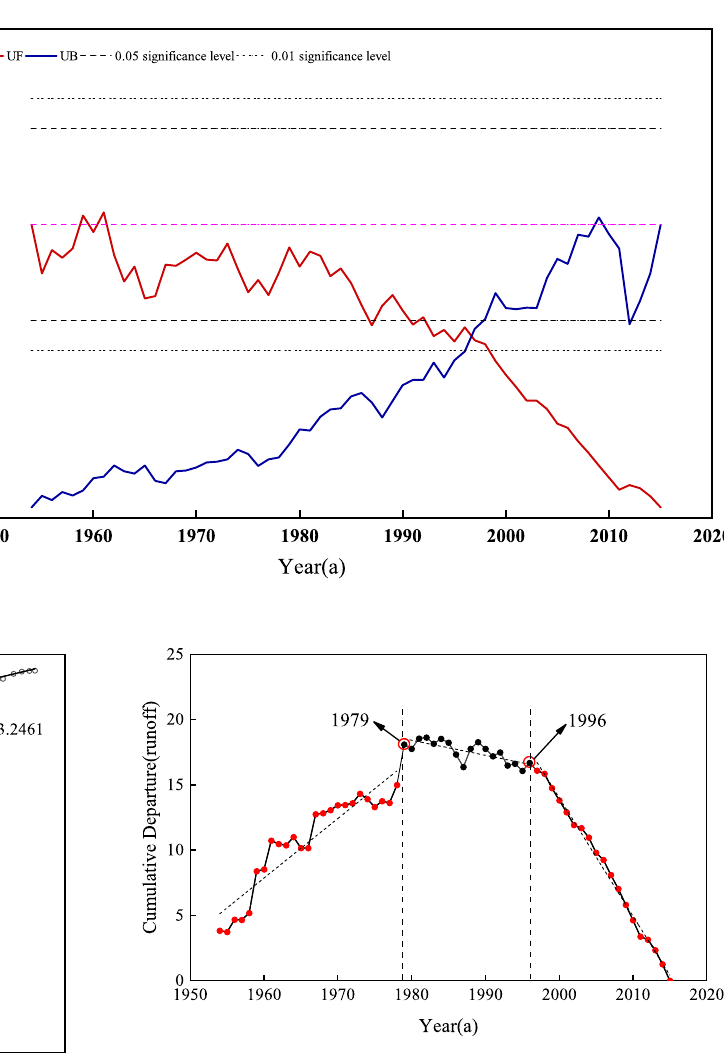
Fig. 3 Runoff M-K test curve in